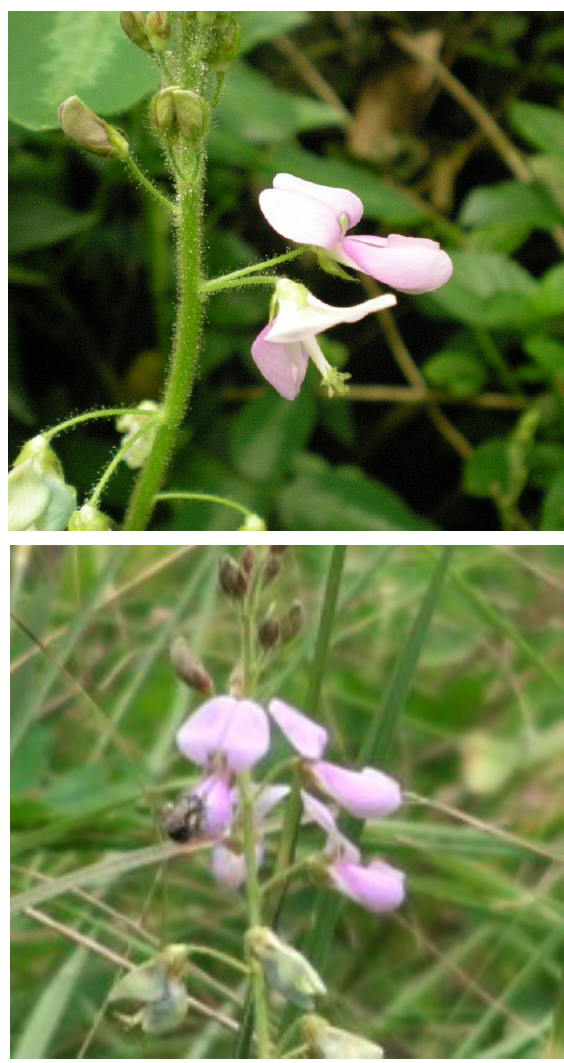
F IGURE 1. A tripped and untripped flower of D. setigerum (above, photo DS), and a small solitary bee (Lasioglossum/Pseudapis sp.) foraging at tip of keel complex in untripped D. setigerum; an illegitimate visit that does not trigger explosive pollen release (below, photo